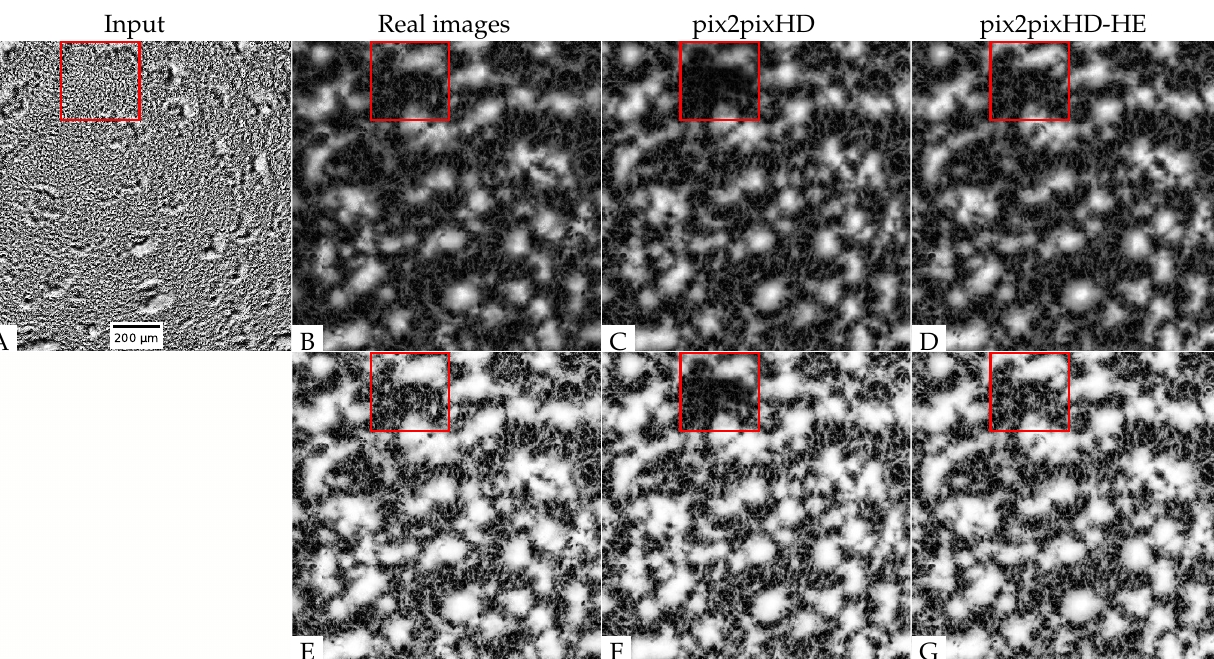
Figure 5. Model performance at the 543 min point in one training movie: ( A ) Input phase-contrast image; ( B ) ground truth tdTomato fluorescent image; ( C ) synthesized fluorescent image (pix2pixHD), the red box indicates a region where the pix2pixHD model fails to accurately reproduce the original image features; ( D ) synthesized fluorescent image (pix2pixHD- HE); ( E ) histogram-equalized ground truth tdTomato fluorescent image; ( F ) histogram-equalized synthesized fluorescent image (pix2pixHD), the red box indicates a region where the pix2pixHD model fails to accurately reproduce the original image features; ( G ) histogram-equalized synthesized fluorescent image